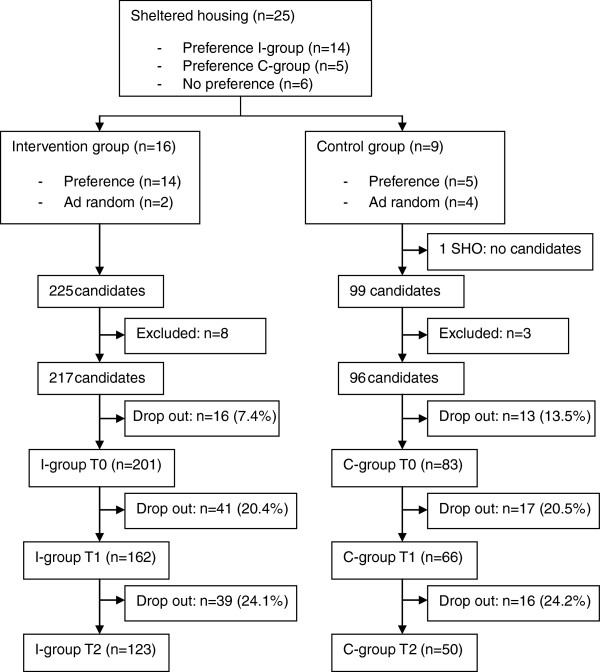
Health promotion intervention: Recruitment process.